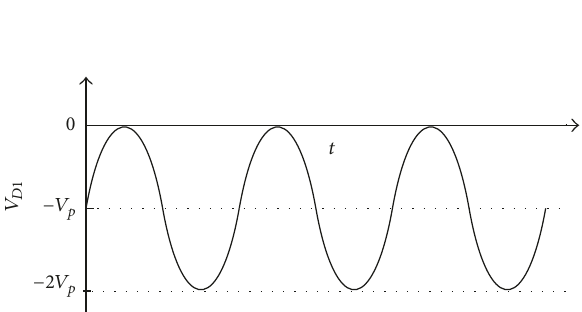
Figure 2: Voltage waveform across 𝐷 1